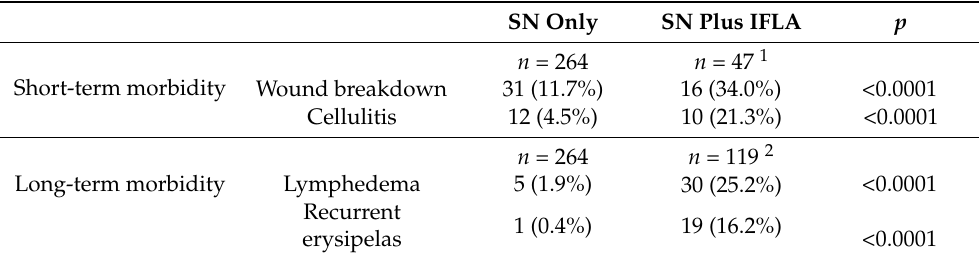
Table 1. Results of the GROINSS-V-I study: short- and long-term morbidity after sentinel lymph node dissection